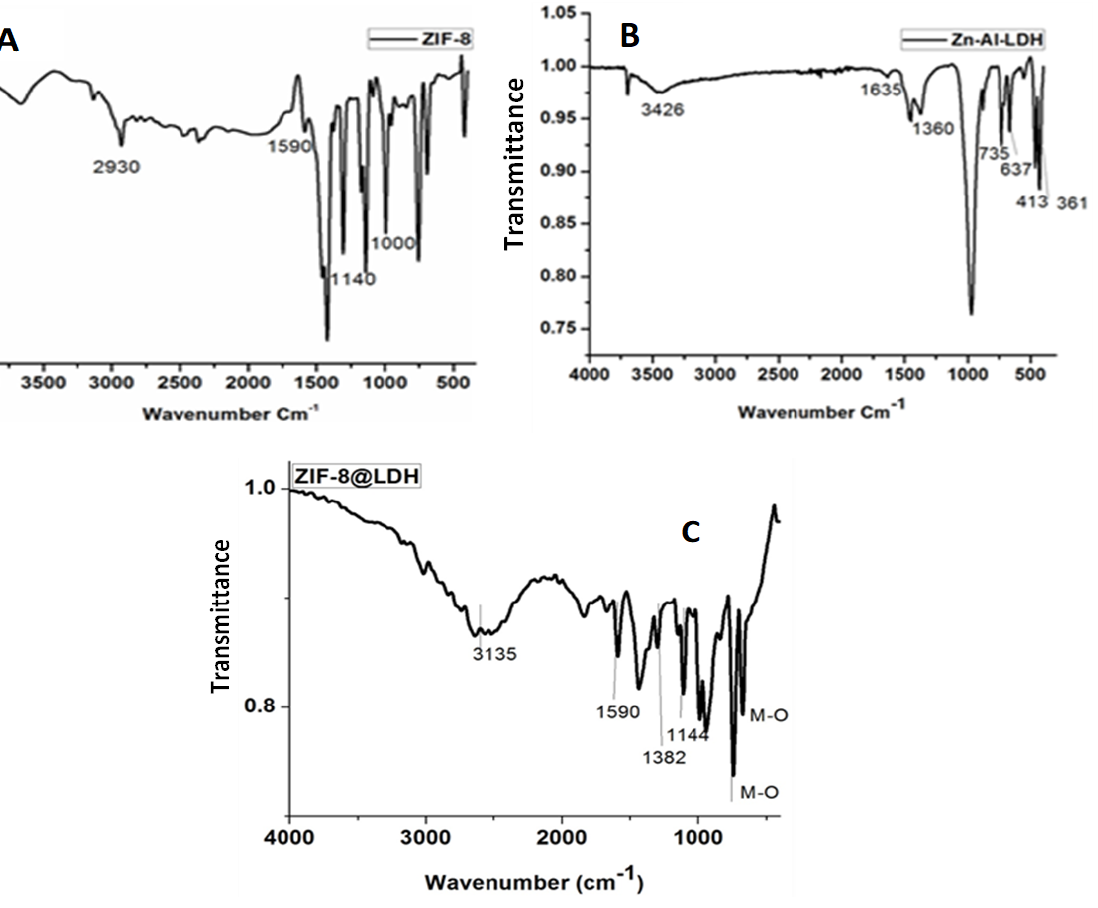
Figure 2. The FTIR spectrum of ( A ) ZIF − 8, ( B ) Zn − Al − LDH, and ( C ) Zn − Al-LDH@ZIF − 8 nanocom- The FTIR spectrum of ( A ) ZIF–8, ( B ) Zn–Al–LDH, and ( C ) Zn–Al-LDH@ZIF–8 posite.